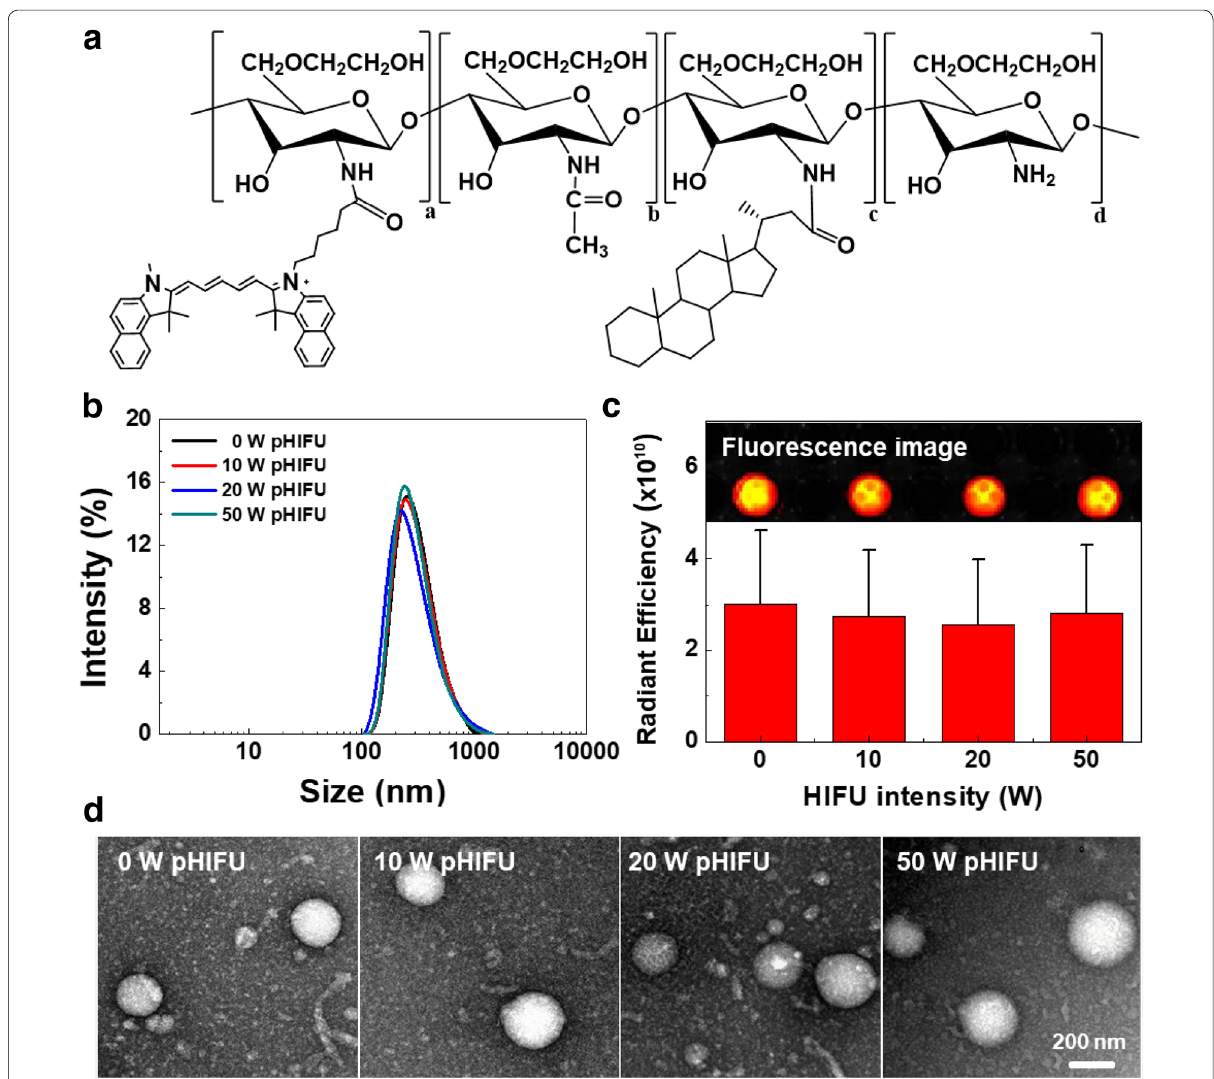
Fig. 1 In vitro physicochemical properties of fluorescent dye-labeled glycol chitosan nanoparticles (FCNPs). a Structure of FCNPs. b Hydrodynamic size distribution of FCNPs after treatment of 10, 20, and 50 W pHIFU. c Fluorescence stability of FCNPs after treatment of 10, 20, and 50 W pHIFU. d Transmission electron microscope (TEM) images of FCNPs after treatment of 10, 20, and 50 W pHIFU. Scale bar indicates 200